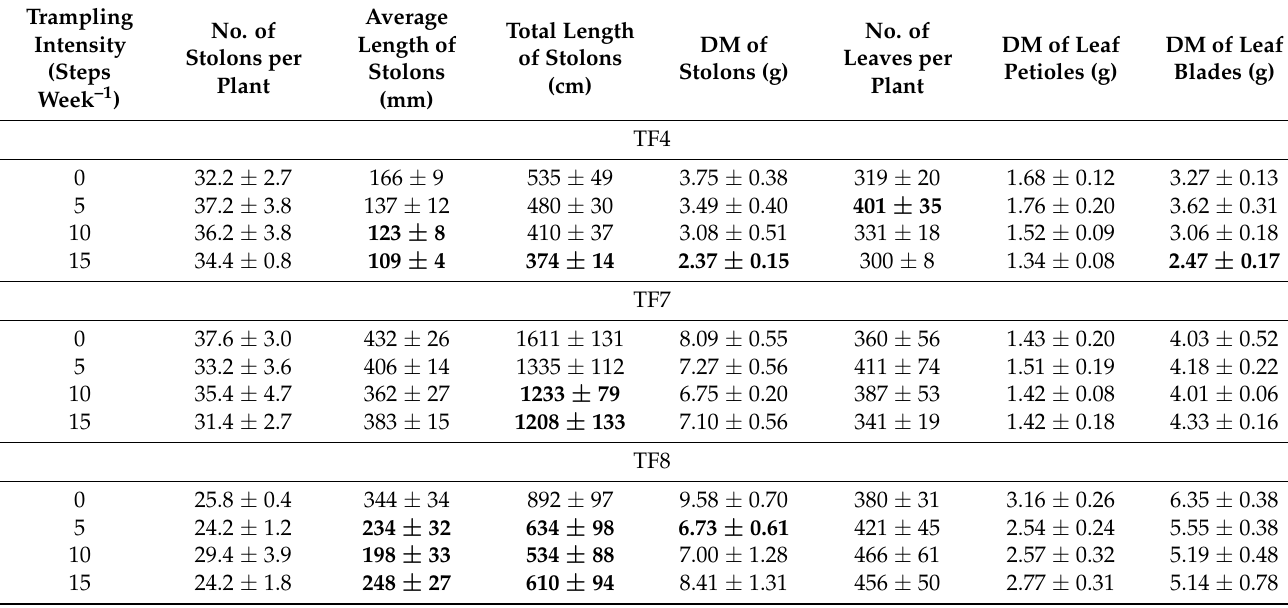
Figure 7. Effect of increasing cutting intensity on shoot dry mass ( A ) and root dry mass ( B ) of Trifolium fragiferum plants of different accessions. Data are means ± SE from five plants. Measurements were performed after six weeks of treatment plus three weeks of recovery. Asterisks indicate statistically significant difference ( p < 0.05) from control for the respective accession. Number of stolons was the parameter least sensitive to cutting, but stolon growth and leaf growth was affected for all accessions, though, to different extents (Table 3). Thus, TF2 showed significant reduction of these parameters by all cutting intensities, but for TF7 leaf growth was not significantly affected by single cutting. For TF4, single cutting did not